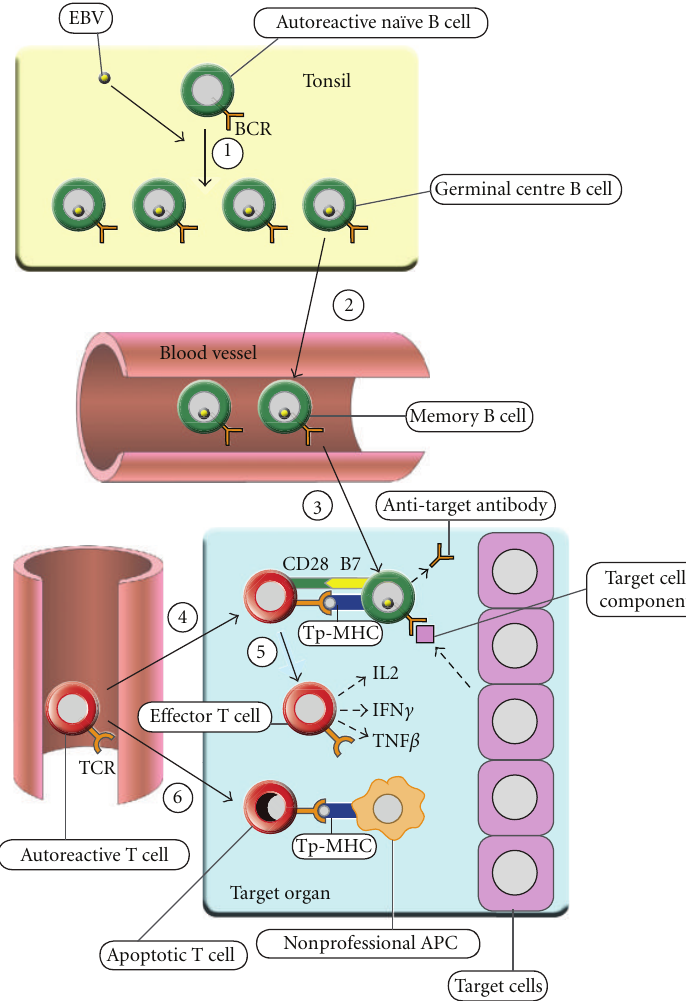
Figure 1: Proposed role of EBV infection in the development of chronic autoimmune diseases. During primary infection EBV infects autoreactive na¨ıve B cells in the tonsil, driving them to enter germinal centres where they proliferate and di ff erentiate into latently infected autoreactive memory B cells (path 1) which then exit from the tonsil and circulate in the blood (path 2). The number of EBV-infected B cells is normally controlled by EBV-specific cytotoxic CD8+ T cells, which kill proliferating and lytically infected B cells, but not if there is a defect in this defence mechanism. Surviving EBV-infected autoreactive memory B cells enter the target organ where they take up residence and produce oligoclonal IgG and pathogenic autoantibodies which attack components of the target organ (path 3). Autoreactive T cells that have been activated in peripheral lymphoid organs by cross-reacting foreign antigens circulate in the blood and enter the target organ where they are reactivated by EBV-infected autoreactive B cells presenting target organ peptides (Tp) bound to major histocompatibility complex (MHC) molecules (path 4). These EBV-infected B cells provide costimulatory survival signals (B7) to the CD28 receptor on the autoreactive T cells and thereby inhibit the activation-induced T-cell apoptosis which normally occurs when autoreactive T cells enter the target organ and interact with nonprofessional antigen-presenting cells (APCs) which do not express B7 costimulatory molecules [168, 169] (Path 6). After the autoreactive T cells have been reactivated by EBV-infected autoreactive B cells, they produce cytokines such as interleukin-2 (IL2), interferon- γ (IFN γ ) and tumour necrosis factor- β (TNF β ) and orchestrate an autoimmune attack on the target organ (Path 5). BCR, B cell receptor; TCR, T cell